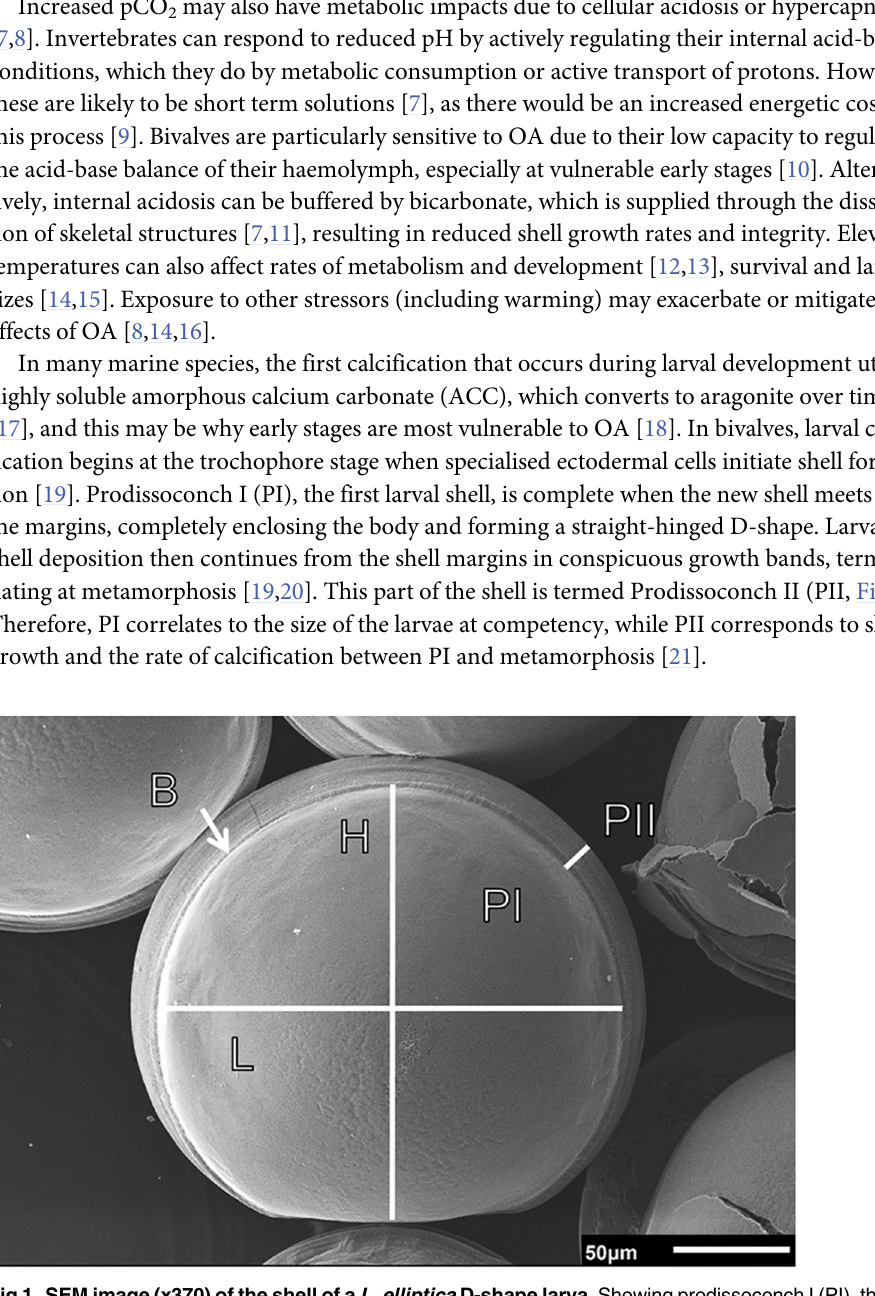
Fig 1. SEM image (x370) of the shell of a L . elliptica D-shape larva. Showingprodissoconch I (PI), the boundary(B) betweenPI and prodissoconch II (PII) and the narrow bandof PII. H and L indicate measurements of shell height and length, respectively, of PI. Scale bar as